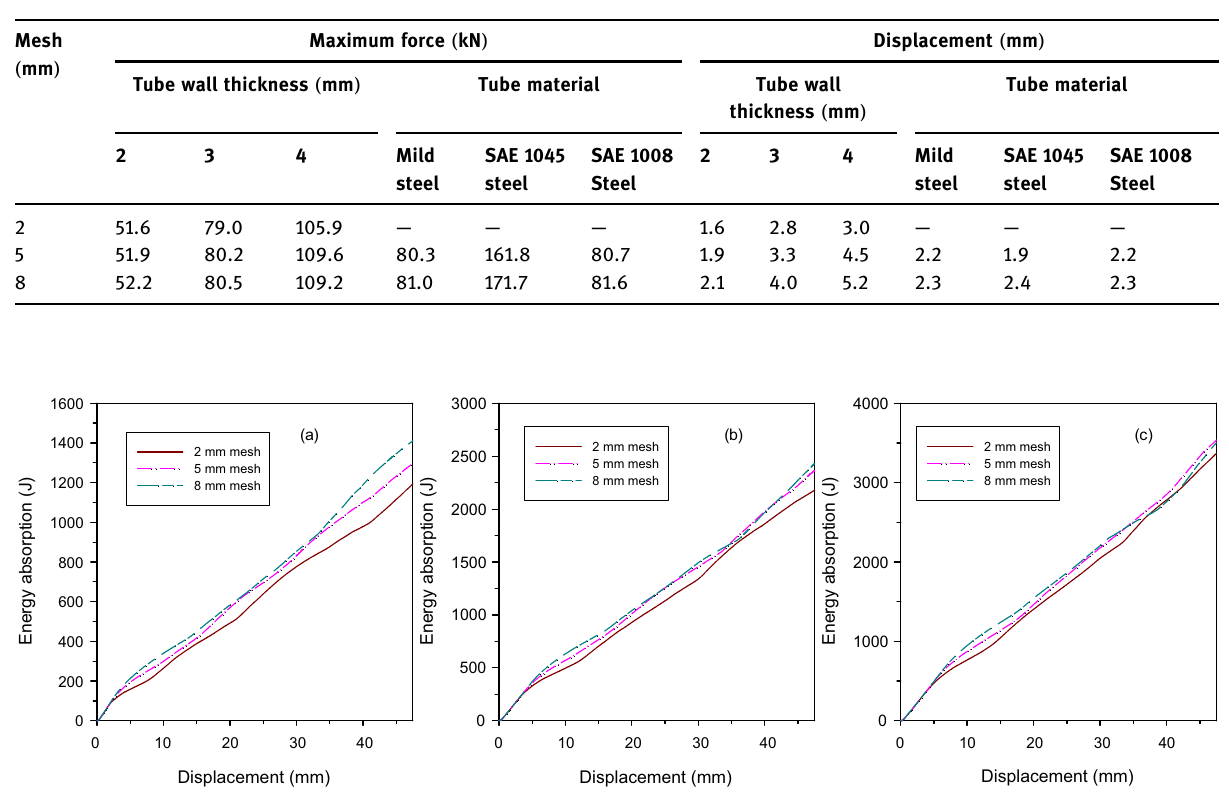
Figure 23: Energy absorption generated during loading from three mesh size with three di ff erent wall thicknesses. ( a ) 2 mm, ( b ) 3 mm, and ( c ) 4 mm.